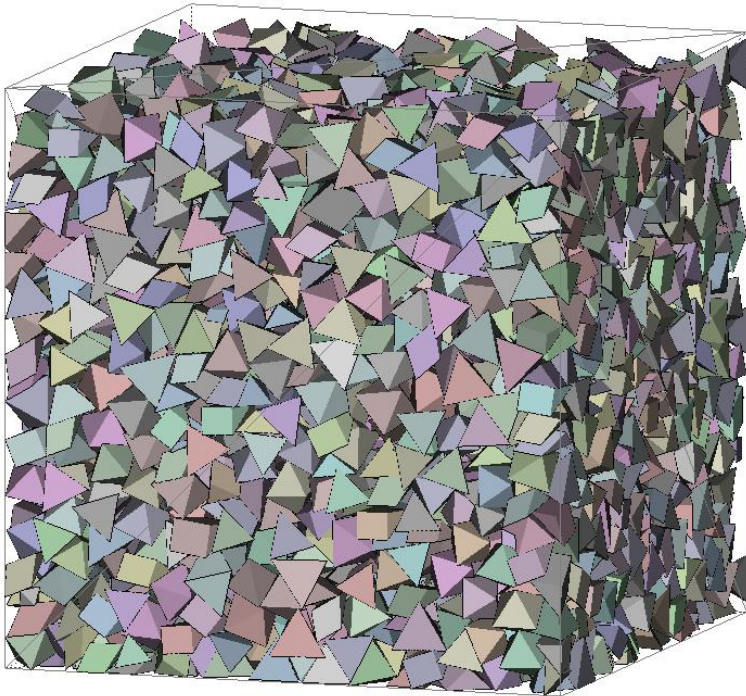
Figure 5. Arrangement of particles for Fraction 1.